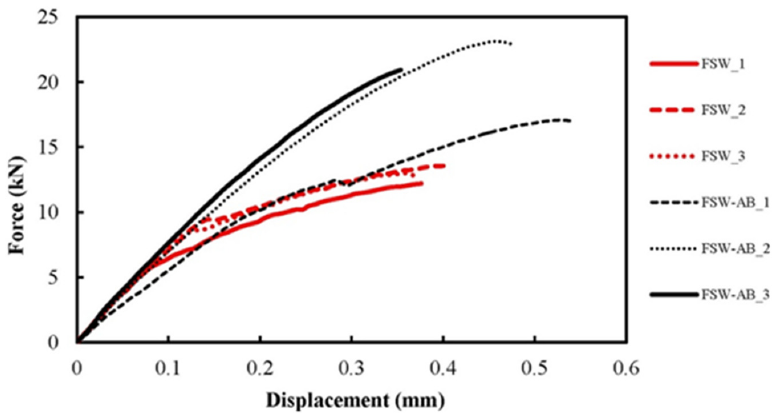
Figure 9. Force–displacement curves of FSW and FSW ‐ AB joints [40].